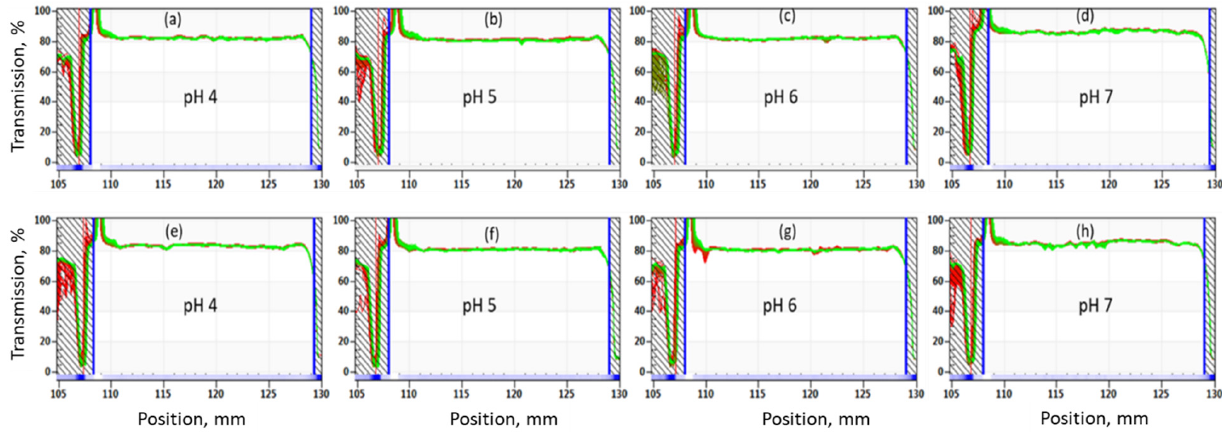
Figure 8. Accelerated stability analysis at 60 °C for 1 wt.% OF50-M in 3.5% NaCl brine at ( a , e ) pH 4, ( b , f ) pH 5, ( c , g ) pH 6, and ( d , h ) pH 7. The simulated stability duration was 6 months and runtime of experiment was 31 h. Samples were run in duplicate.